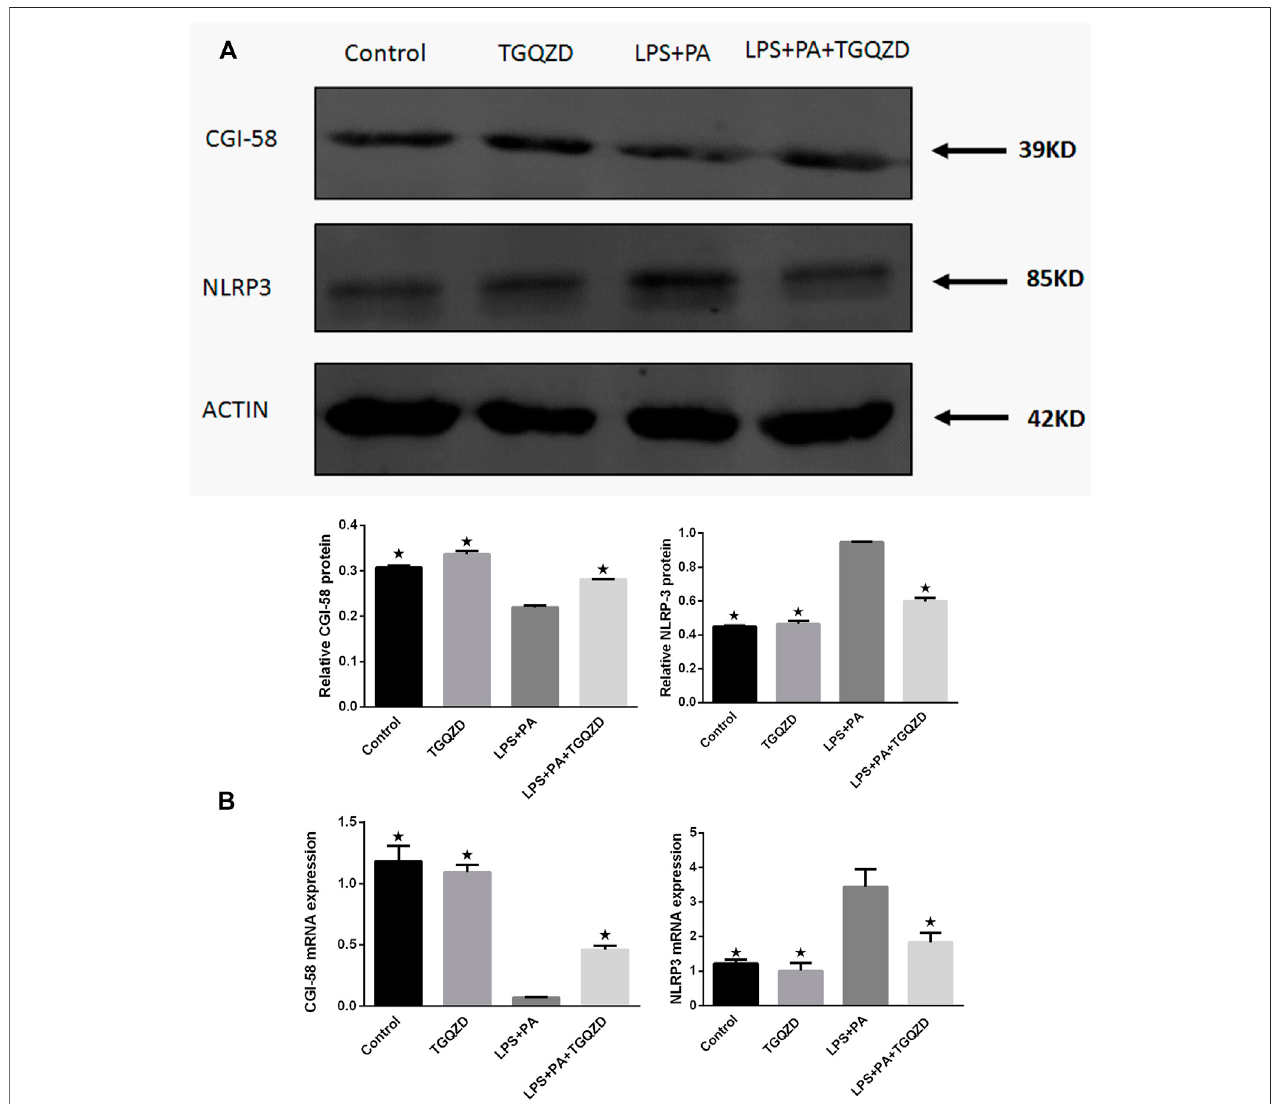
FIGURE 7 | Effect of TGQZD on CGI-58 and NLRP3 in fl ammasome of HepG-2 cells. (A) Representative images of Western blot showing CGI-58 and NLRP3 in fl ammasome protein expression in HepG-2 cells in the different groups. (B) Quantitation of CGI-58 and NLRP3 in fl ammasome mRNA expression in HepG-2 cells in different groups. ACTIN was used as a loading control. * p < 0.05 vs. LPS + PA Group, alone, ( n =